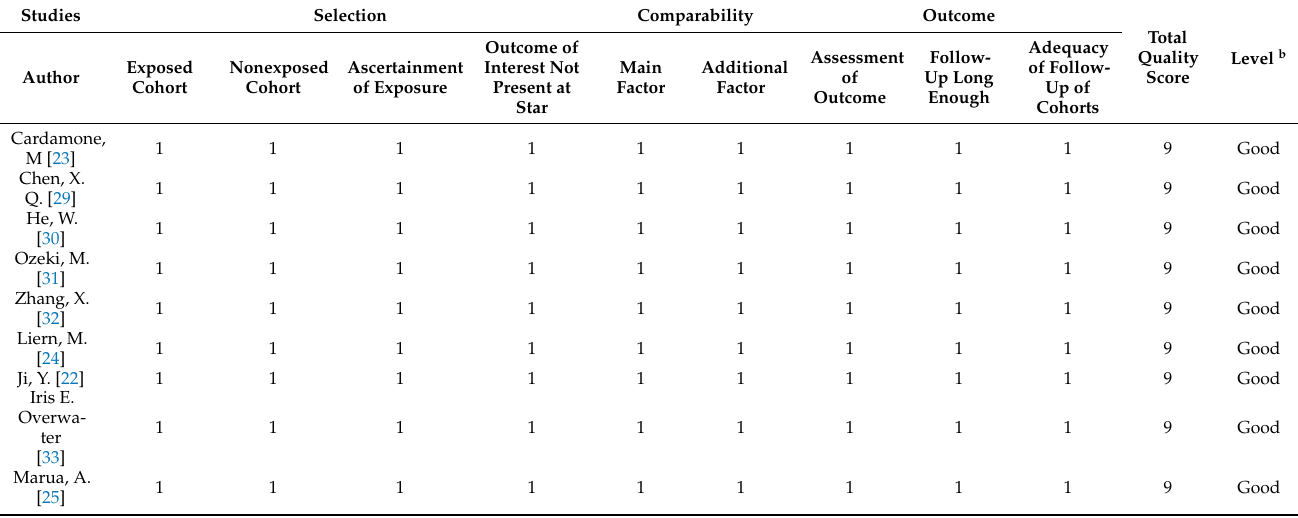
Table 3. List of the quality of all studies based on the NOS a